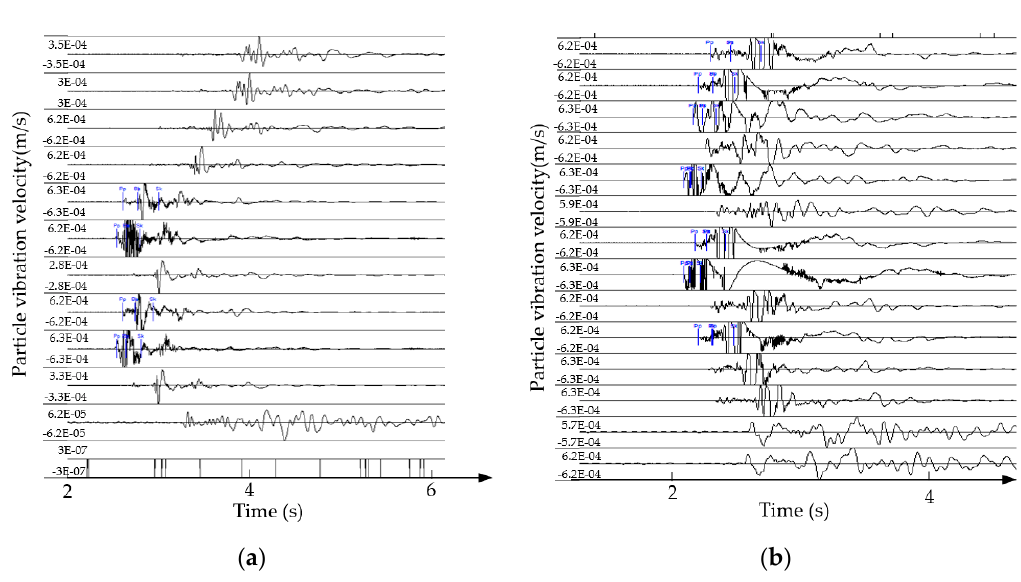
Figure 4. Waveforms of the two mine seismicities on 7 October: ( a ) 17:49 event; ( b ) 18:11 event.